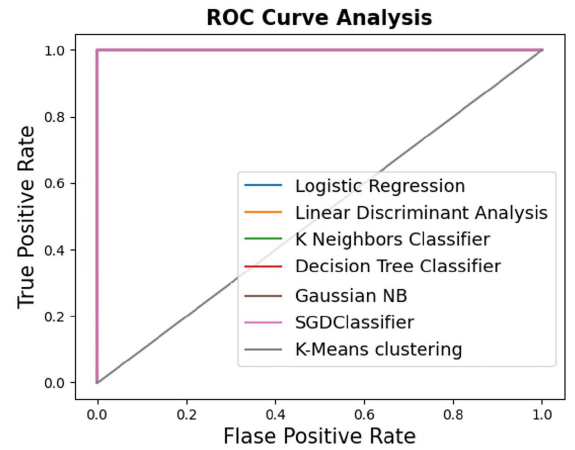
Figure 15. The ROC curves of ML models for